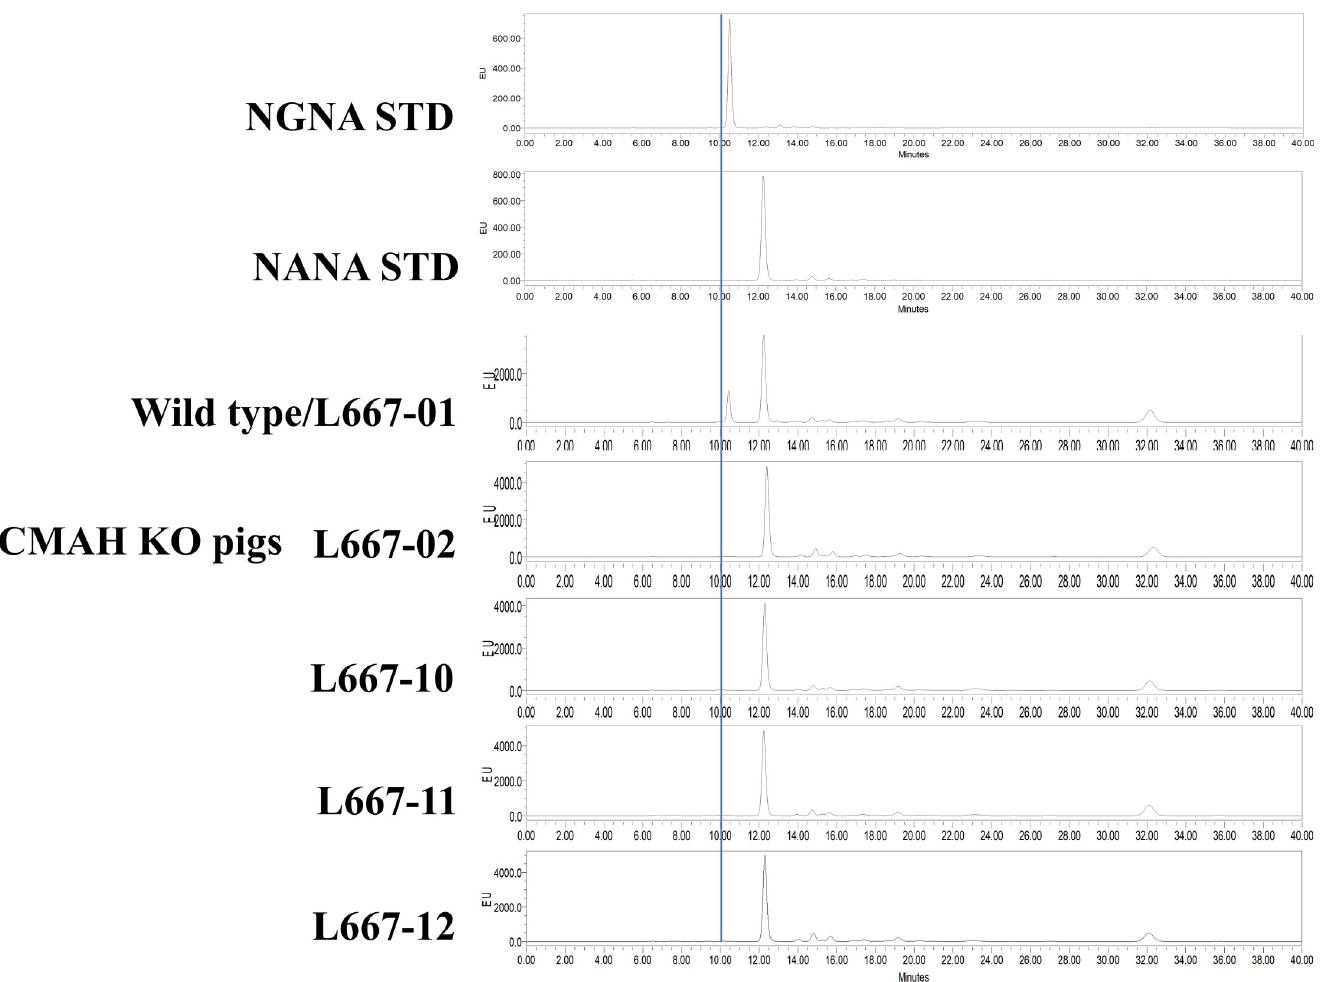
Fig 5. Expression of NGNA/NANA in the tissues of CRISPR/Cas9 CMAH mutant founders. L667-02, -10, -11 and -12 and their wild-type littermate (L667-01) were analysed by HPLC. NGNA STD and NANA STD are standard samples of NGNA and NANA, respectively. The blue line indicates a retention time of 10 min.